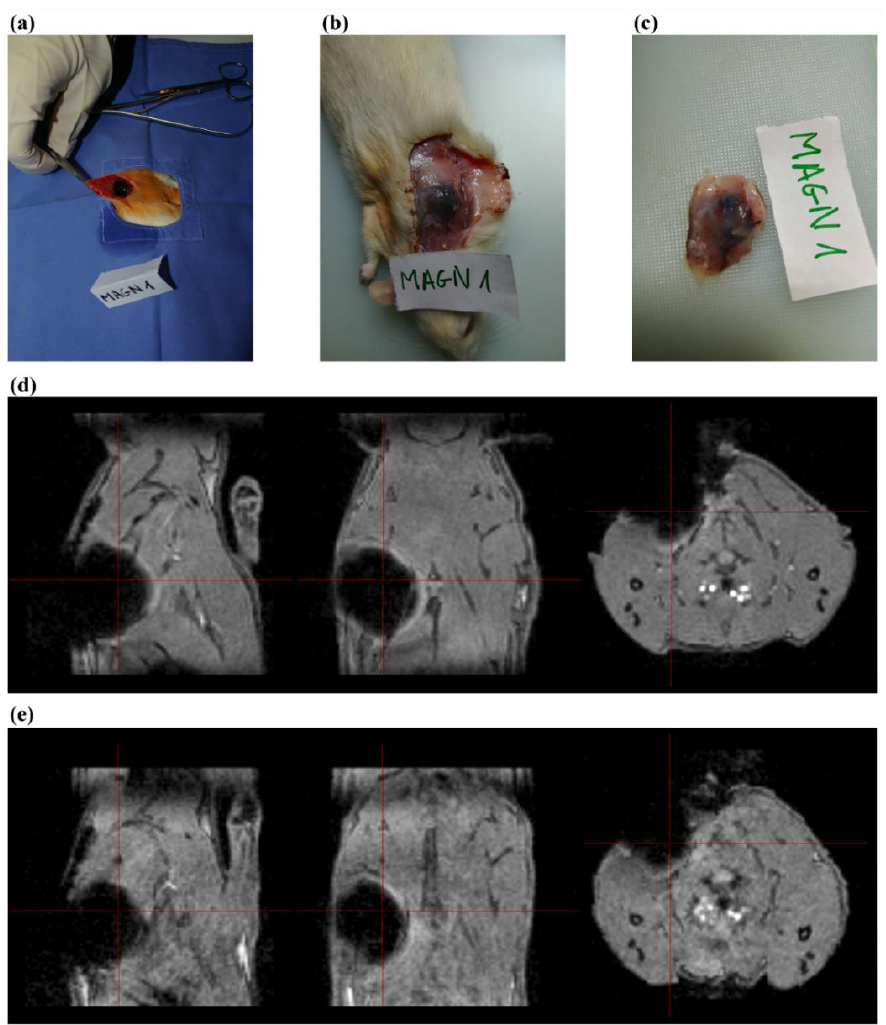
Figure 3. ( a – c ) Samples were implanted under the skin at the backside of the neck of Wistar rats. ( d ) Magnetic resonance imaging (MRI) scan on the 1st day following the implantation. ( e ) MRI scan on the 7th day following the implantation. The samples gave a good contrast in MRI even after a week.